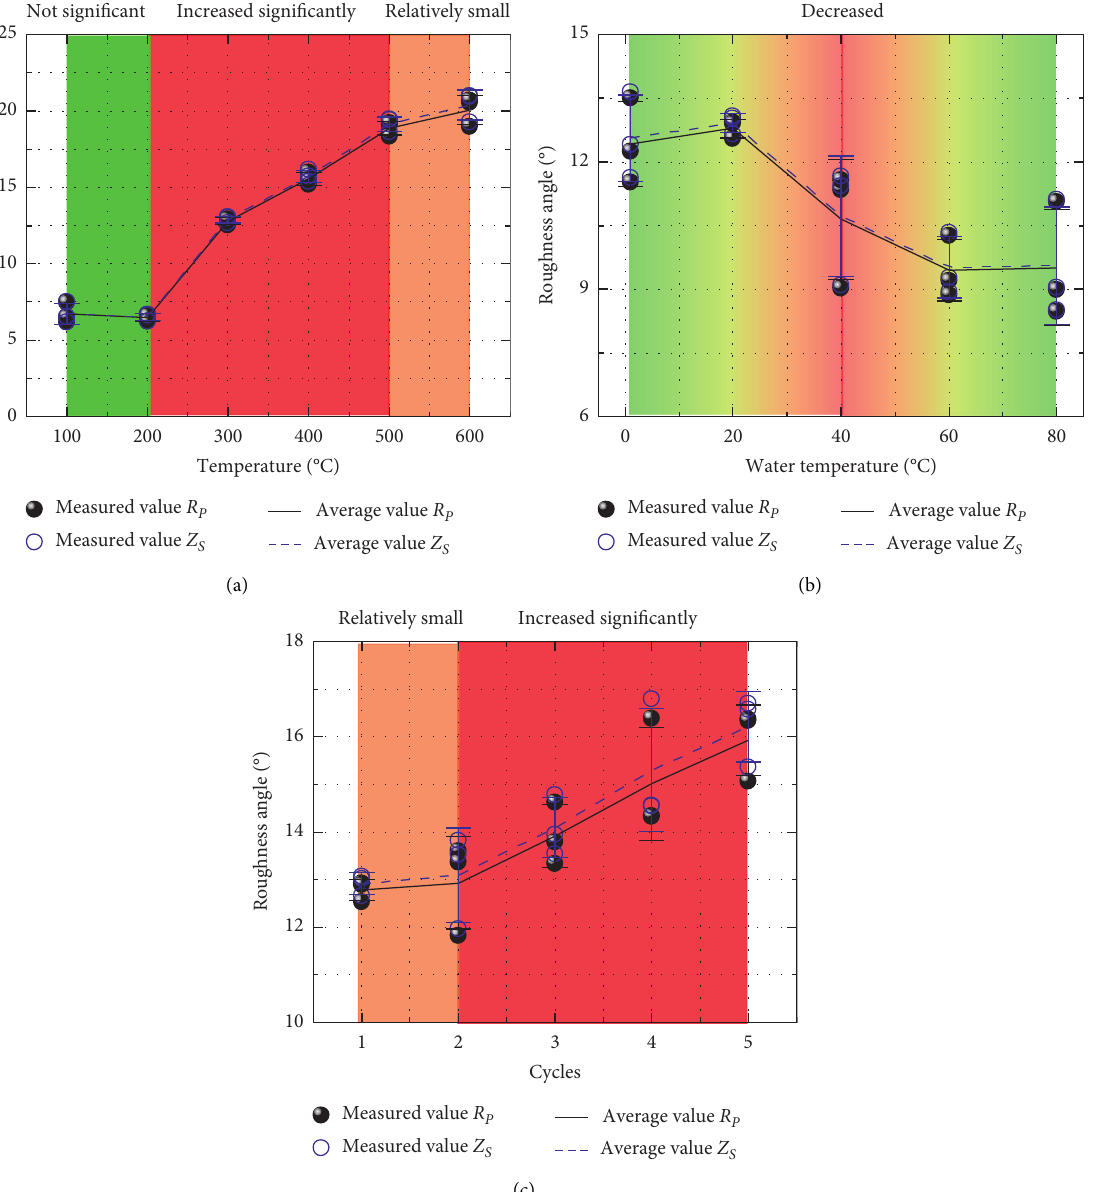
Figure 11: Roughness angle of the split surface of the specimen under different conditions of water cooling at high temperatures. (a) HDR temperature. (b) Water temperature. (c) The number of heating-cooling